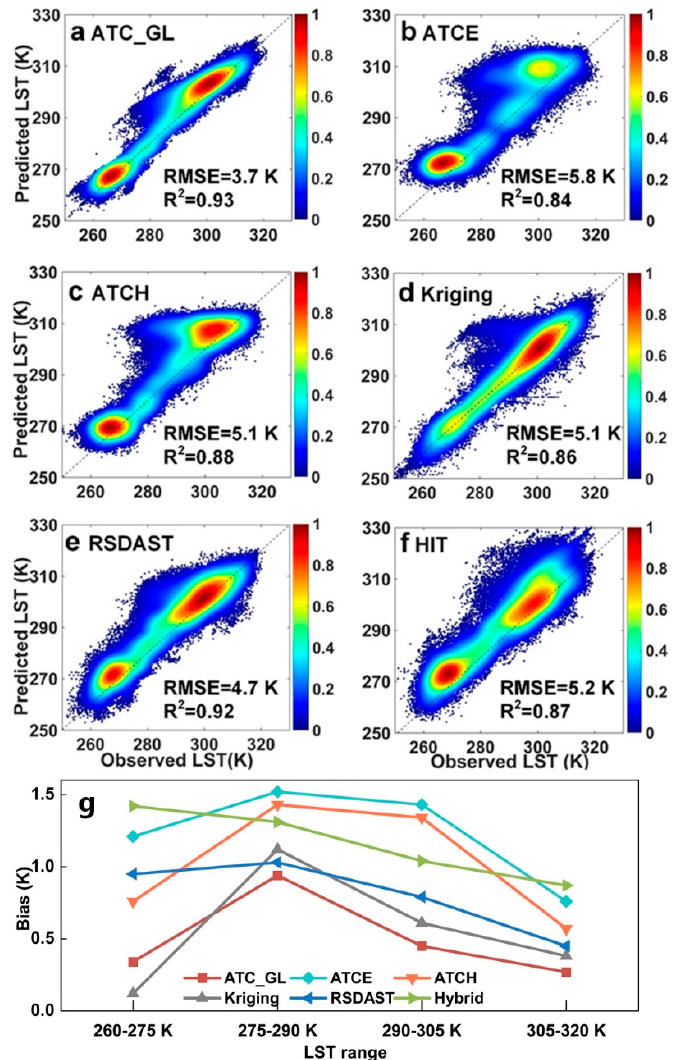
Figure 11. Accuracy evaluations of the reconstructed LSTs using different methods under overcast conditions. Subfigure g shows the bias of different methods in different LST ranges.